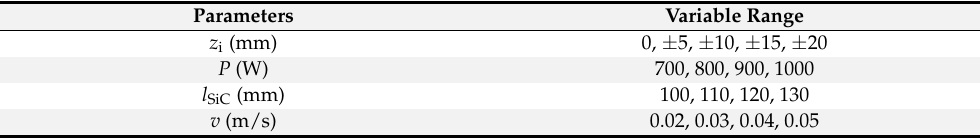
Table 2. The variable reactor and operation parameters.